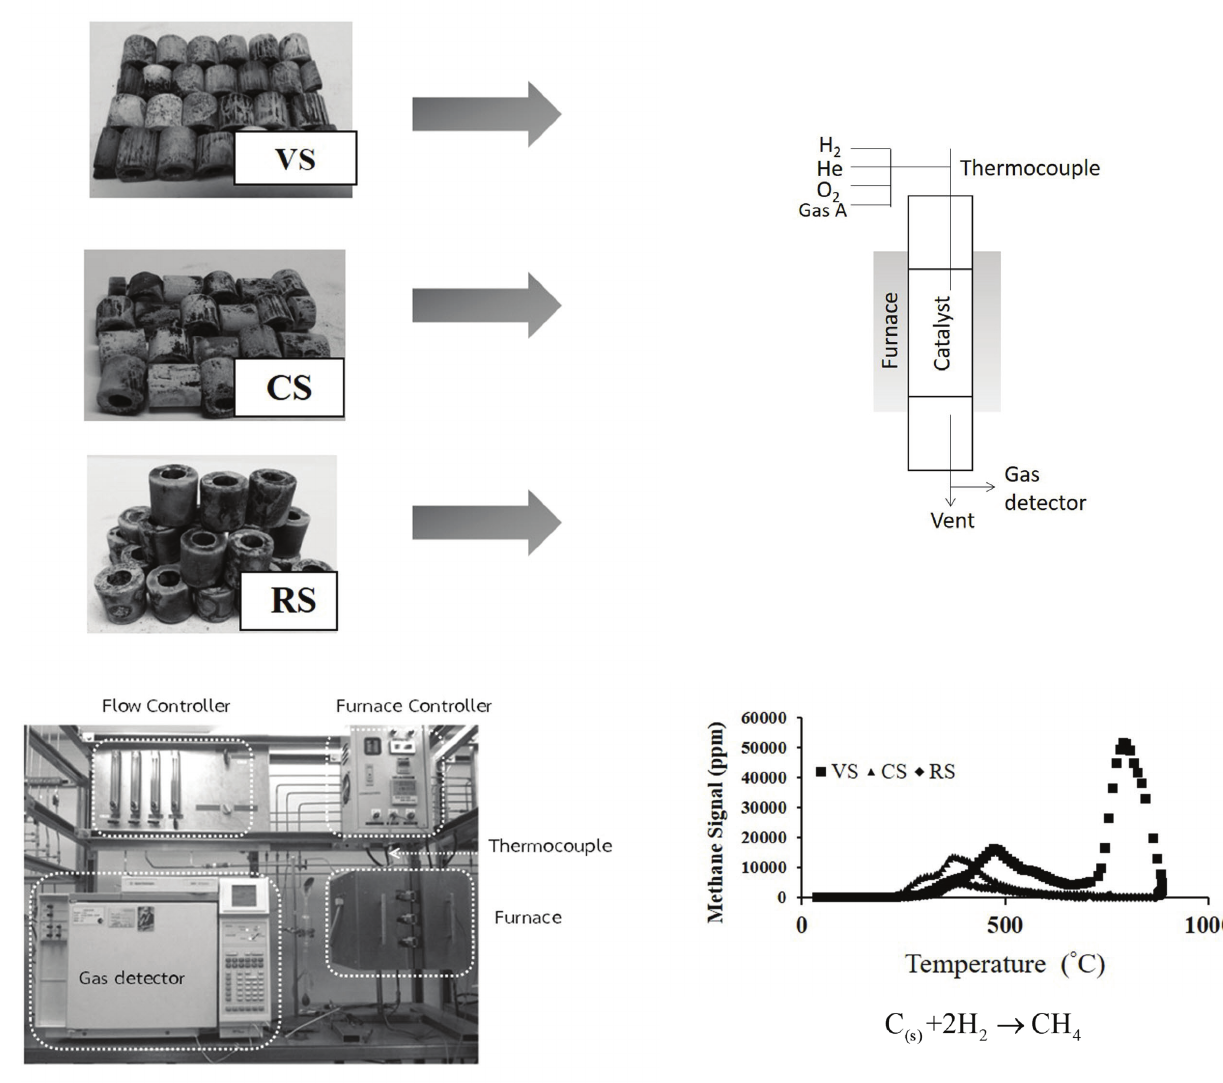
Fig. S14 – Experimental set-up for determination of coke formation on catalytic